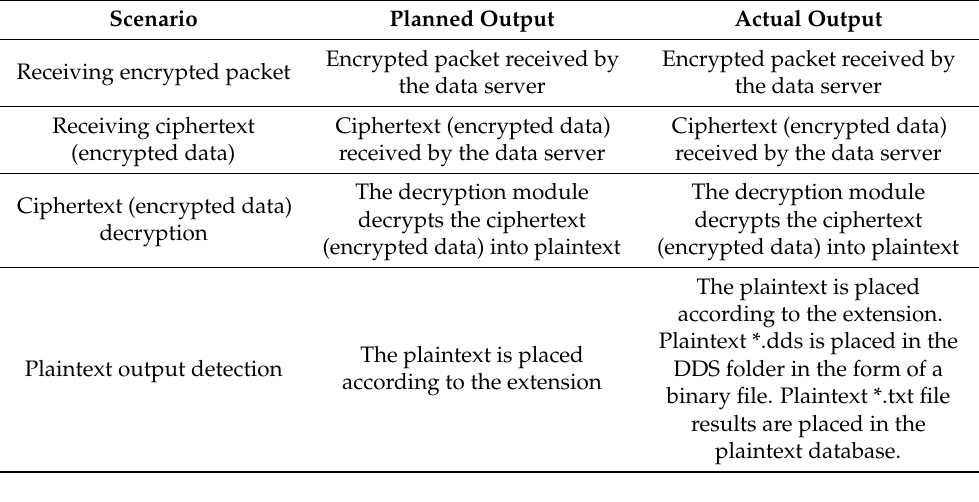
Table 5. Data receiving and decryption